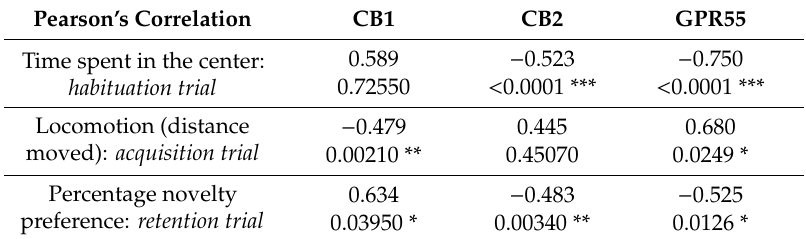
Table 1. Pearson’s correlation between endocannabinoid receptors (CB1, CB2, and GPR55) and behavioral parameters related to memory measured by novel object recognition test in 5xFAD transgenic mice. Pearson’s Correlation CB1 CB2